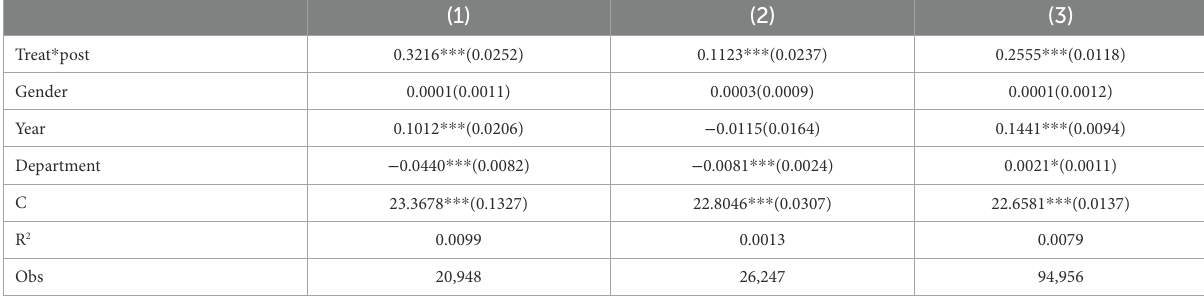
TABLE 8 Discipline heterogeneity effect